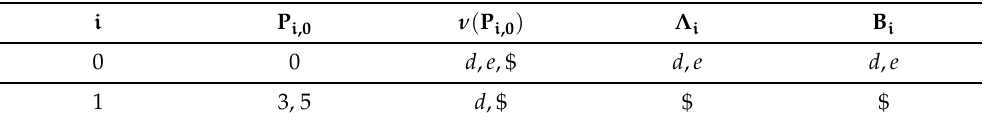
Table 8. The sets of states P i ,0 , the valid lookahead sets ν p P i ,0 q , and the sets Λ i and B i for the specifi- cation Ξ in